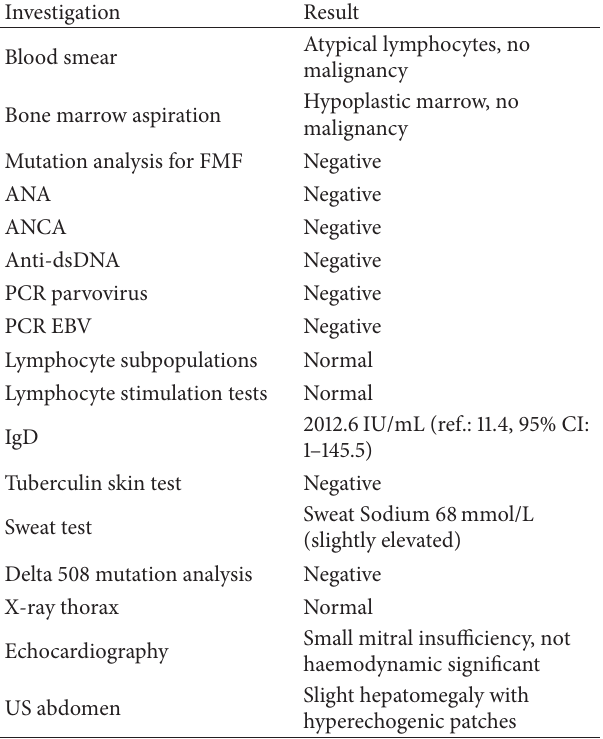
Table 3: Investigations performed at the 5th hospitalisation, threeyears and eight months of